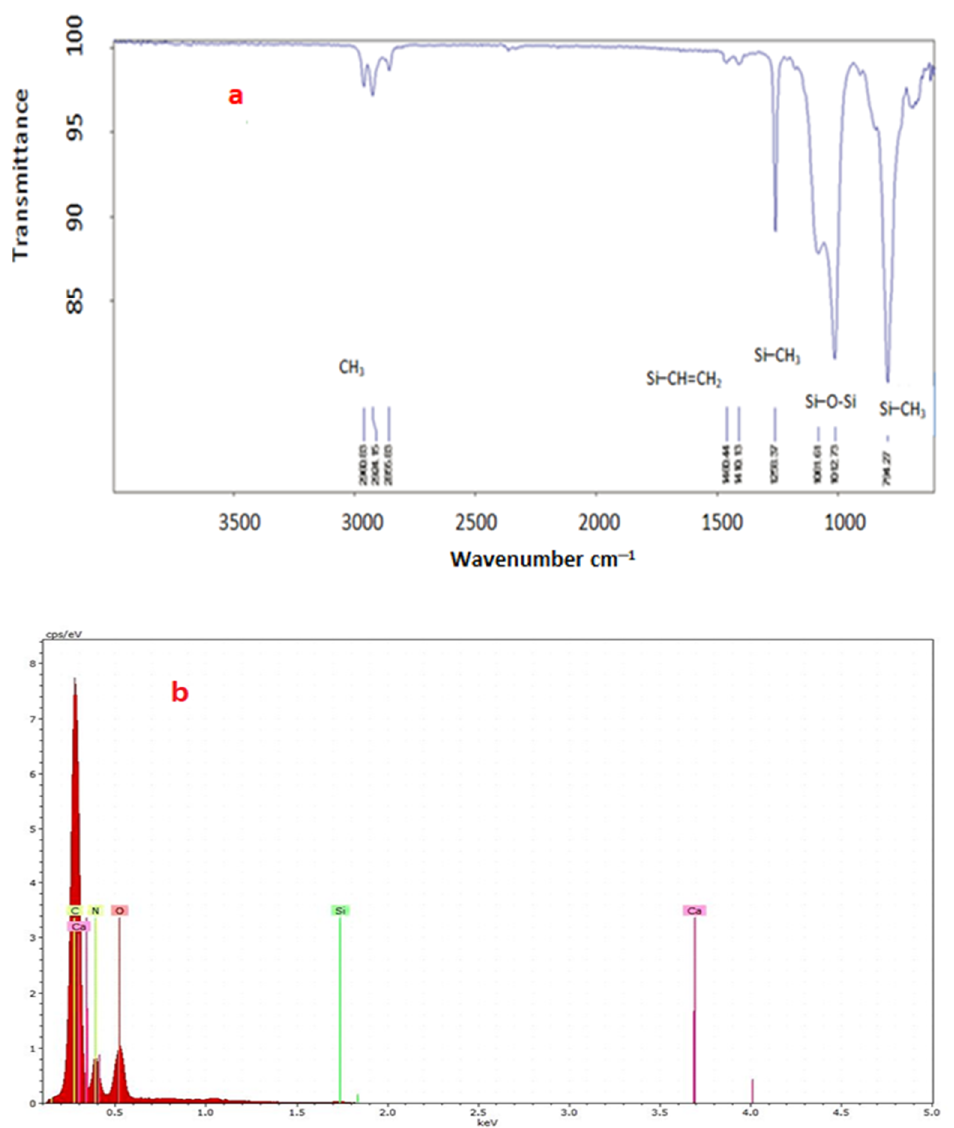
Figure 3. ( a ) FTIR spectra of PDMS membranes. ( b ) EDS analysis of PDMS membranes.